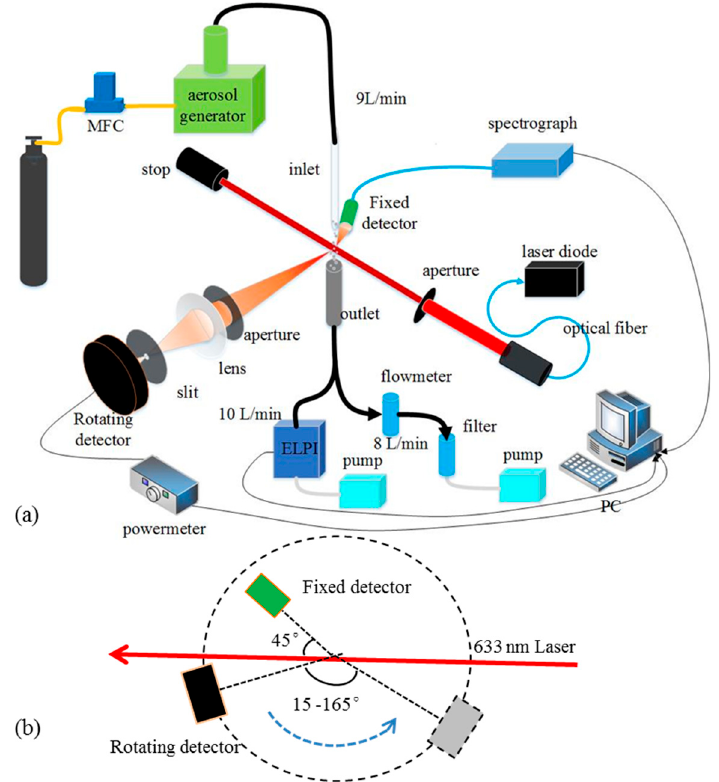
Figure 6. Schematic diagram of the integrated experimental setup ( a ) and the light path ( b ).